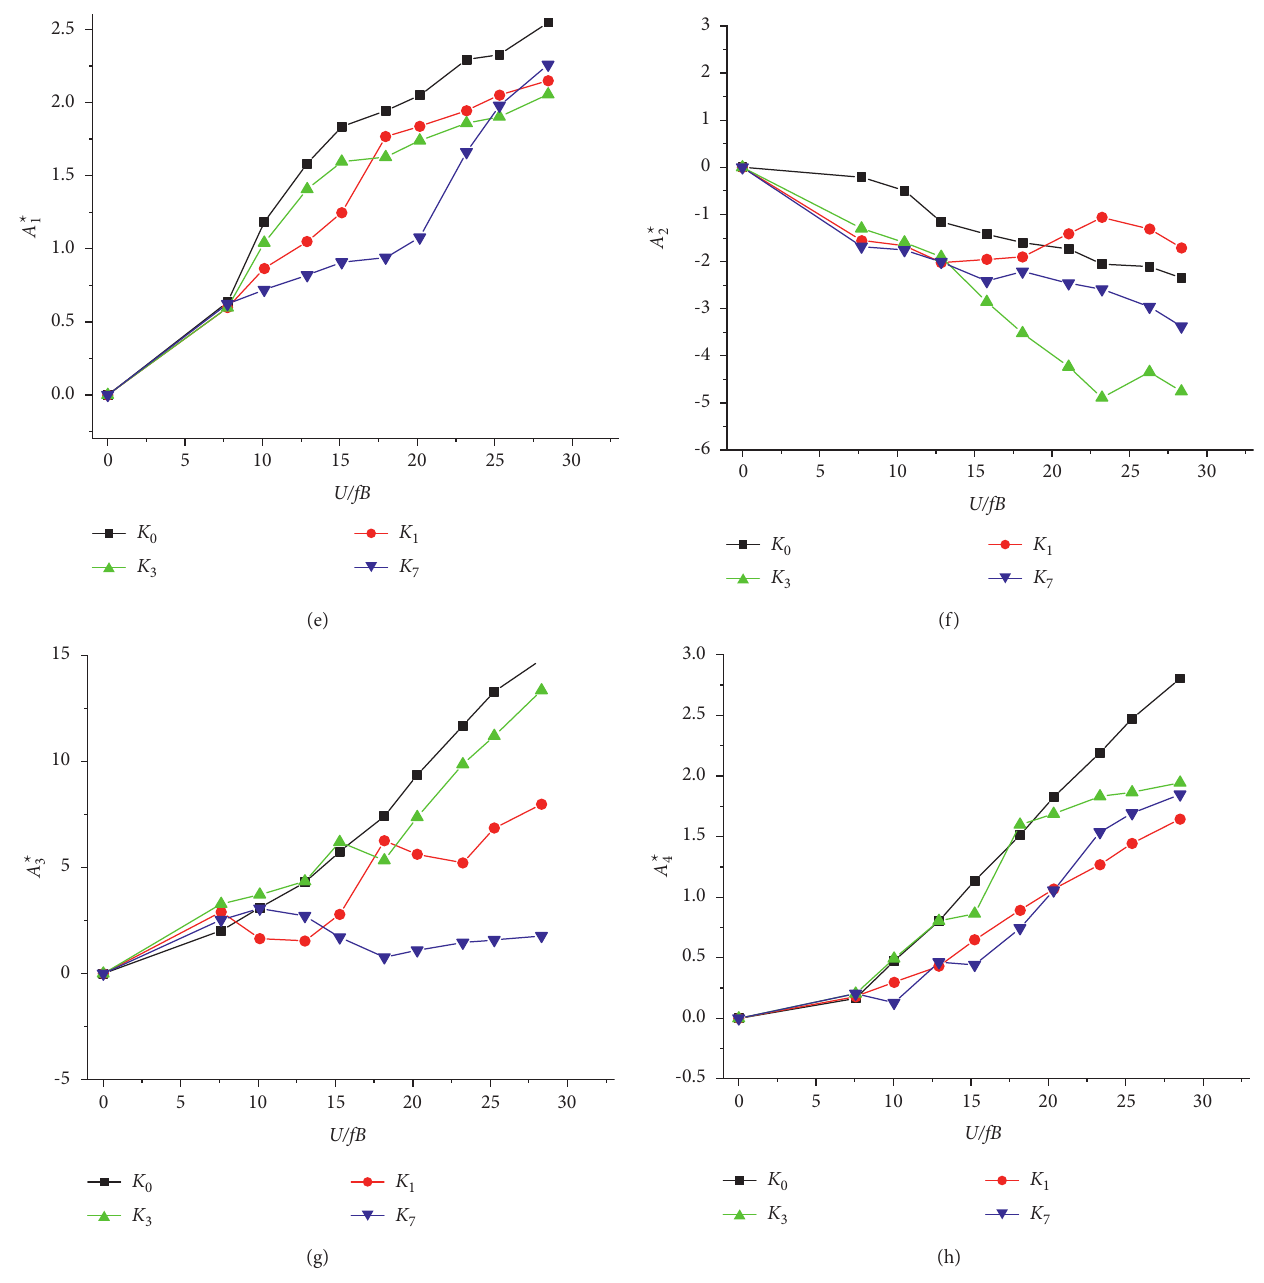
Figure 6: Flutter derivatives (Cs � 0.0018): (a) H 1 ∗ ; (b) H 2 ∗ ; (c) H 3 ∗ (d) H 4 ∗ ; (e) A 1 ∗ ; (f) A 2 ∗ ; (g) A 3 ∗ ; (h) A 4 ∗